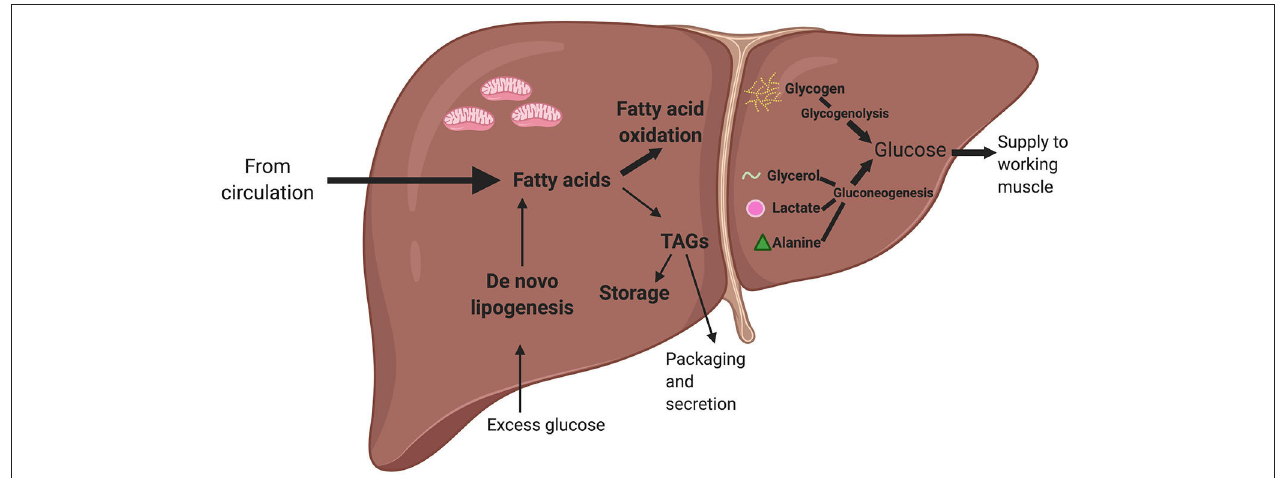
FIGURE 4 | A simplified summary of liver lipid and glucose metabolism. Fatty acids from the circulation can either be used for fatty acid oxidation or converted into triacylglycerides (TAGs), which can either be stored or packed and secreted back to the circulation. When there is excess glucose in the circulation, the liver converts glucose into fatty acids via a process known as de novo lipogenesis. When there is a low level of glucose in the circulation, the pancreatic hormone glucagon triggers the liver to generate glucose. The liver can use glycerol (released by white adipose tissue via lipolysis), lactate (a metabolite produced via anaerobic glycolysis), and alanine (an amino acid) as precursors. The liver can also produce glucose by breaking down glycogen (or stored glucose) via a process called glycogenolysis. The glucose from both gluconeogenesis and glycogenolysis can then be released to working skeletal muscle during exercise. Bold arrows indicate metabolic processes most active during acute exercise. This figure created with